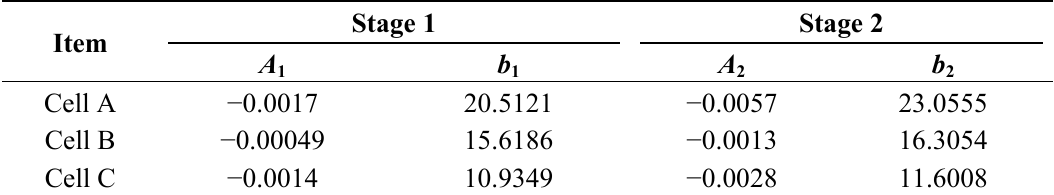
Table 2. The slope and intercept of the two-stage capacity fade.